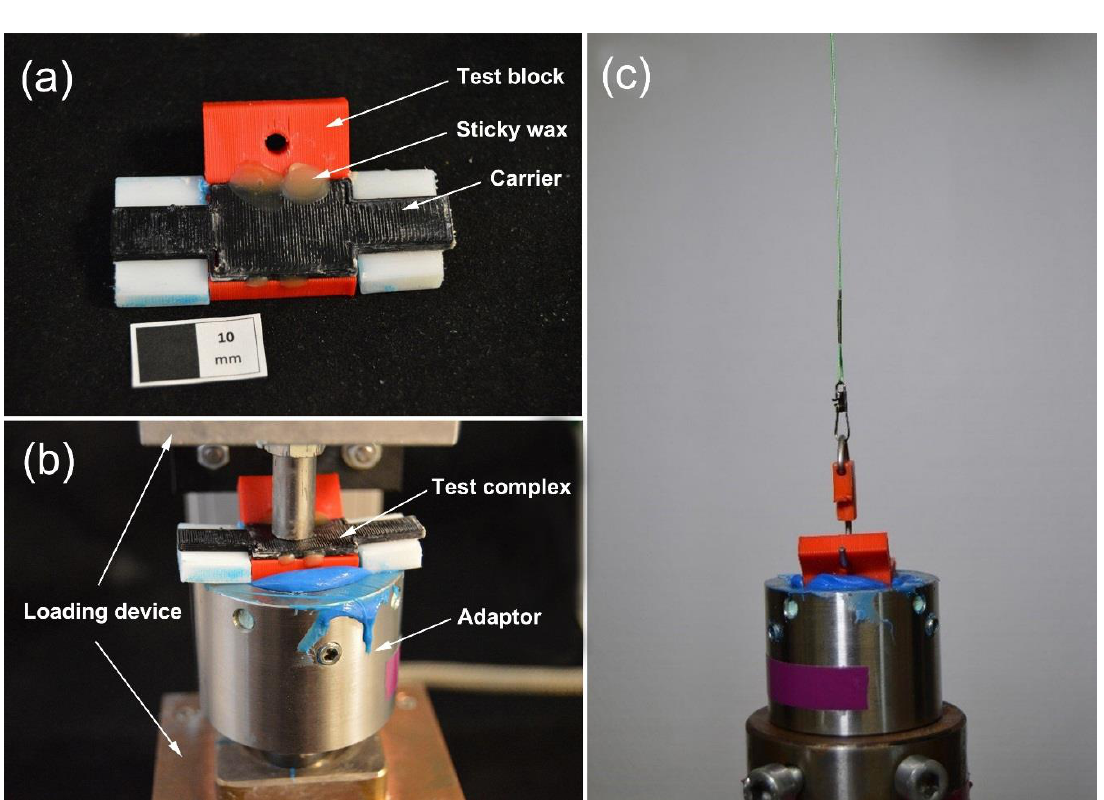
Figure 4. Peel-off strength test. ( a ) A carrier was glued to an acrylonitrile butadiene styrene (ABS) test block using sticky wax to make a test complex (white scale: 10 mm); ( b ) Before impression setting, the test complex was fixed on the cylindrical adaptor by a custom-made loading device with a perpendicular weight of 1.4 kg; ( c ) Peel-off test on the universal testing machine.